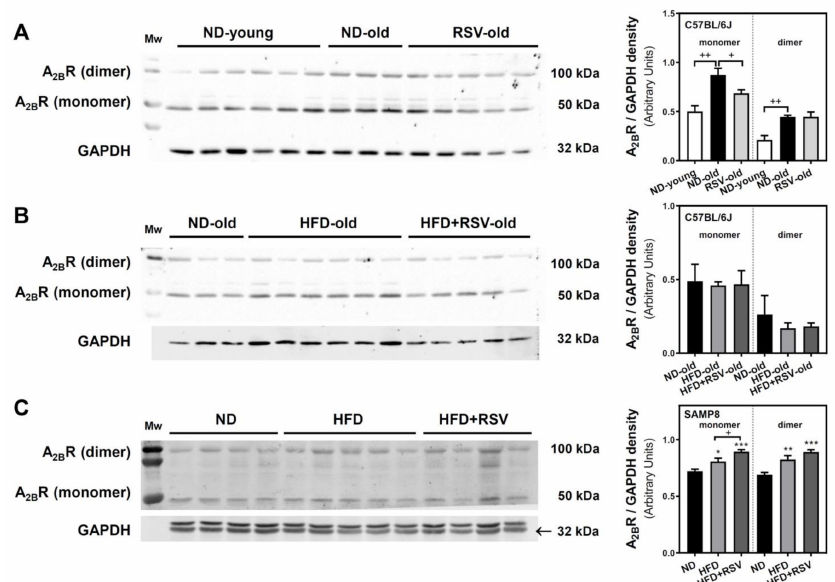
Figure 4. Adenosine A 2B receptor density in the cerebral cortex. Monomeric and dimeric forms of A 2B R were detected by Western blotting assay in the plasma membrane fraction of cerebral cortex of C57BL/6J ( A , B ) and SAMP8 ( C ) mice. Data are mean ± SEM of three-six different samples. GAPDH was used as a gel loading control. The upper GAPDH band in panel C correspond to the A 1 R band. + p < 0.05 and ++ p < 0.01 significantly different from indicated bars according to one-way ANOVA. * p < 0.05, ** p < 0.01 and *** p < 0.001 significantly different from ND group (panel C ) according to one-way